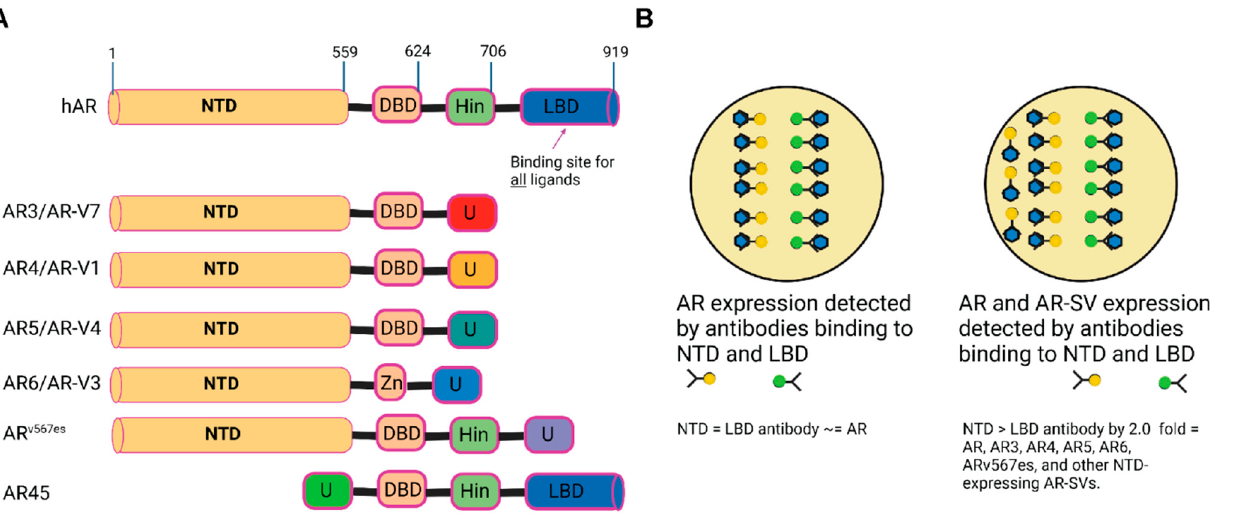
Figure 1. ( A ) AR and AR-SV structure (created using Biorender.com, accessed on 10 December 2022). These are representatives of the 20 AR-SVs clinically detected. ( B ) Diagram representing the method used to detect AR and AR-SVs.